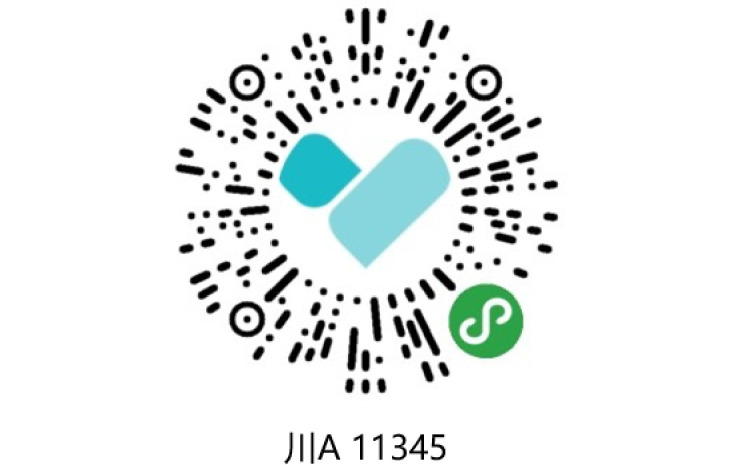
Illustration of an example of the QR codes to trace the epidemic in mainland China.This is the one posted in a public bus in Chengdu City. In the bottom, a Chinese character followed by A11345 is the plate number of this bus, and the character is the abbreviation of Sichuan Province.